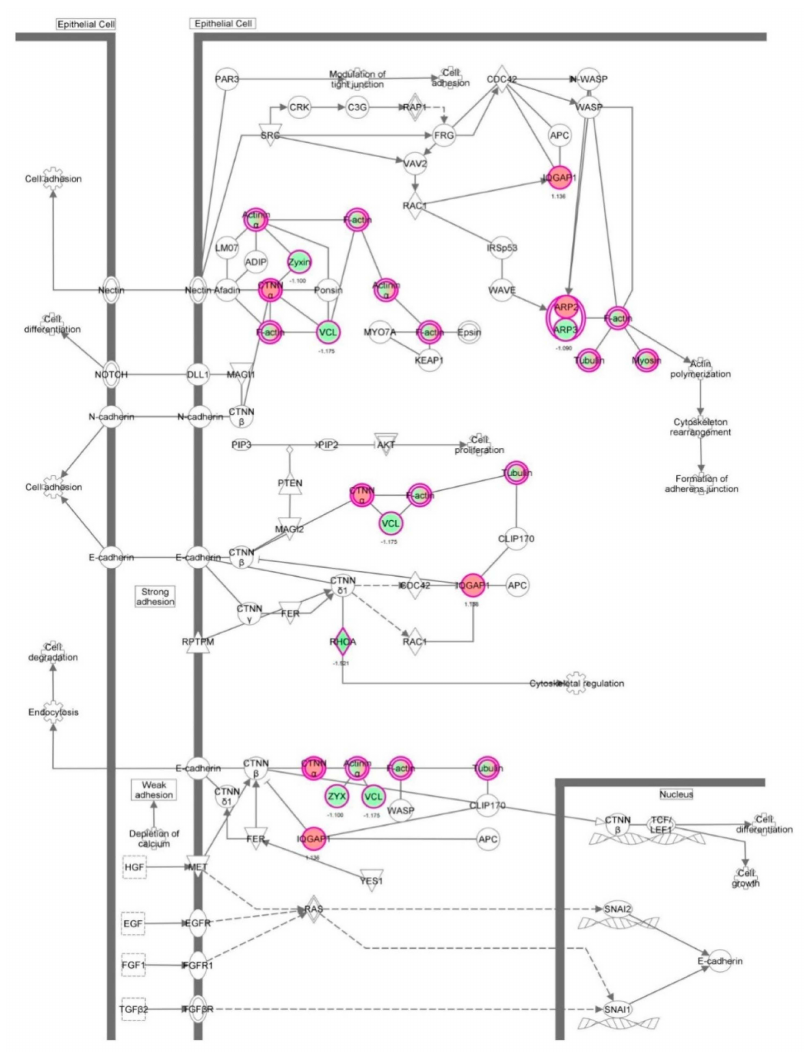
Figure 32. Epithelial adherent junction signaling pathway was regulated by vancomycin in HK-2 cells. HK-2 cells were treated with 50 µ g/mL vancomycin for 24 h and the protein samples were subject to quantitative proteomic analysis. Red indicates an up-regulation; green indicates a down-regulation. The intensity of green and red colors indicates the degree of down- or up-regulation. Solid arrow indicates direct interaction and dashed arrow indicates indirect